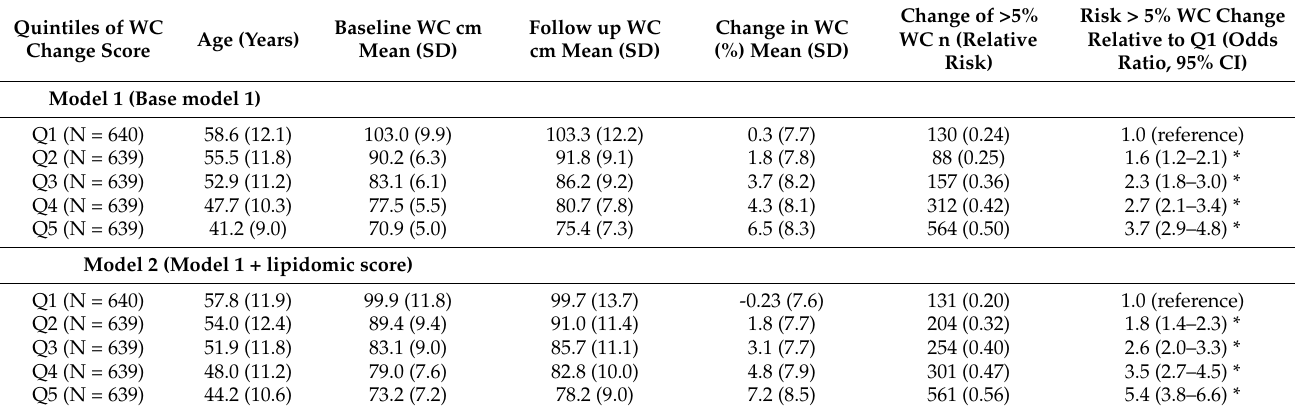
Table 3. Multivariate models predicting gain in WC in Women.